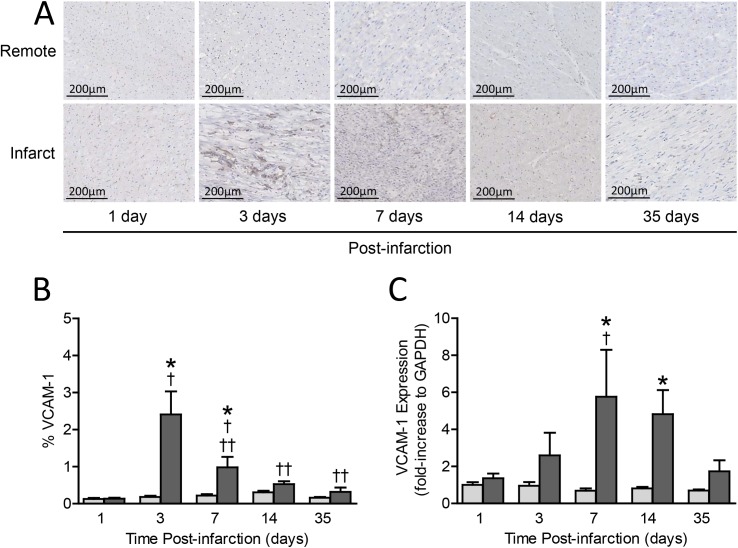
Panel A. Typical examples of VCAM-1 presence in infarct and remote myocardial tissue at 1, 3, 7, 14 and 35 days after myocardial infarction. Brown is VCAM-1. Panel B. Temporal VCAM-1 presence at 1 (n = 4), 3 (n = 4), 7 (n = 5), 14 (n = 6) and 35 days (n = 6) after myocardial infarction. Data are expressed as mean ± SEM. light grey bar = remote tissue, dark grey bar = infarct tissue. * = p<0.05 vs. corresponding remote; † = p<0.05 vs. day 1; †† = p<0.05 vs. day 3. Panel C. Temporal VCAM-1 expression at 1 (n = 6), 3 (n = 5), 7 (n = 6), 14 (n = 6) and 35 days (n = 5) after myocardial infarction. Data are presented as fold-change ± SEM from the VCAM-1 expression in the remote zone on day 1 post-infarct, and corrected for expression of the housekeeping gene glyceraldehyde-3-phosphate dehydrogenase (GAPDH). light grey bar = remote tissue, dark grey bar = infarct tissue. * = p<0.05 vs. corresponding remote; † = p<0.05 vs. day 1.